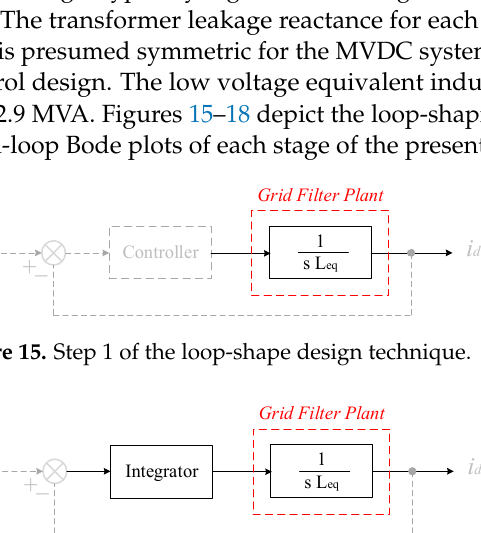
Figure 14. The simplified current control loop of a grid-connected power converter.